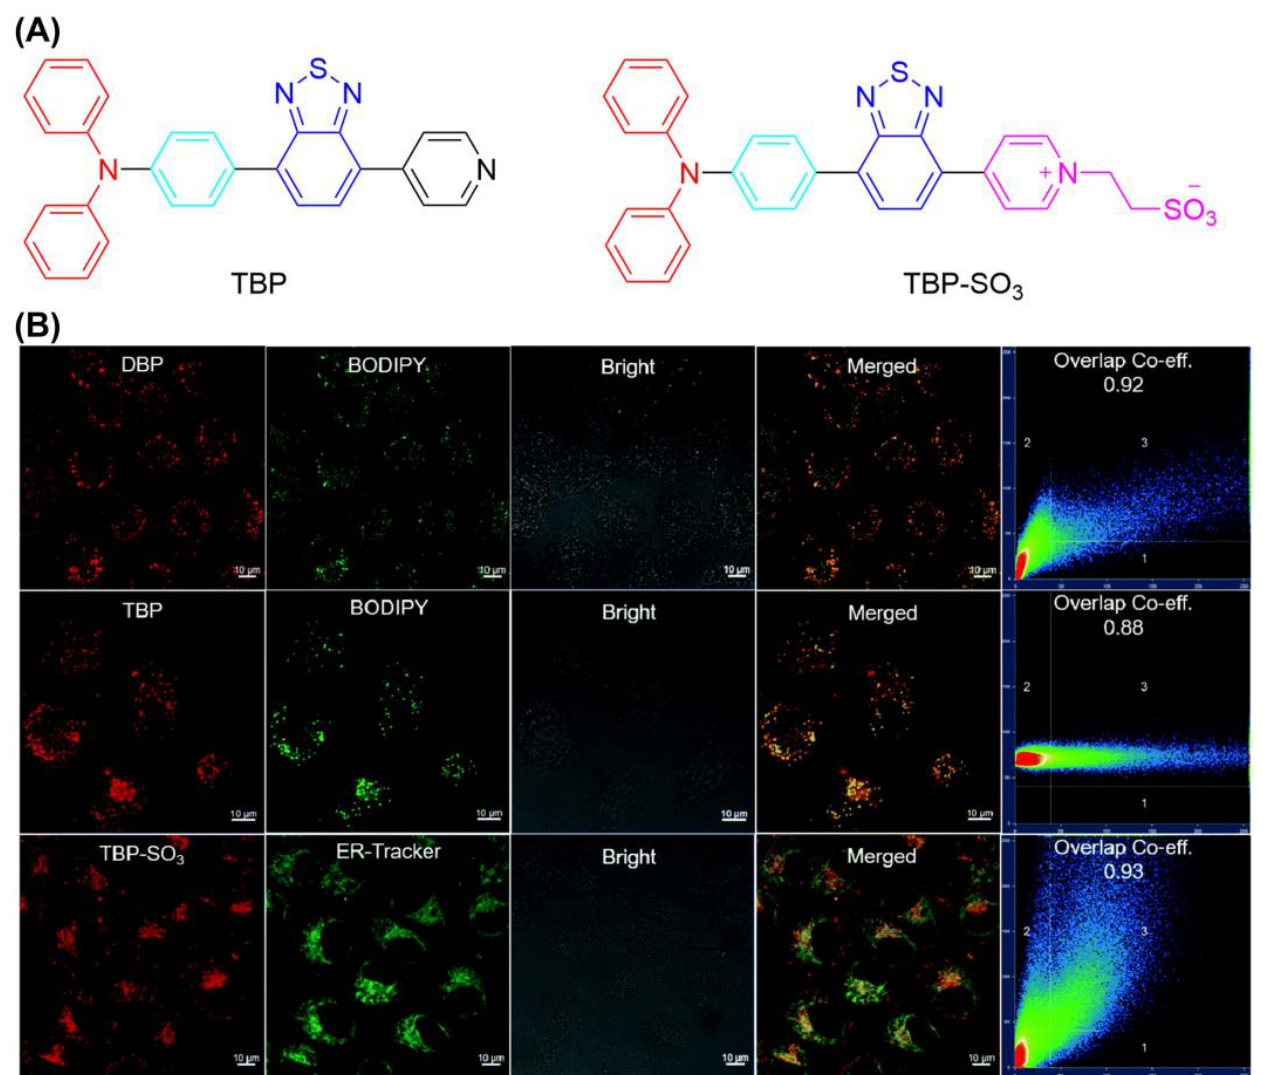
Figure 14. ( A ) Chemical structure of TBP and TBP-SO3; ( B ) CLSM images of HeLa cells stained with